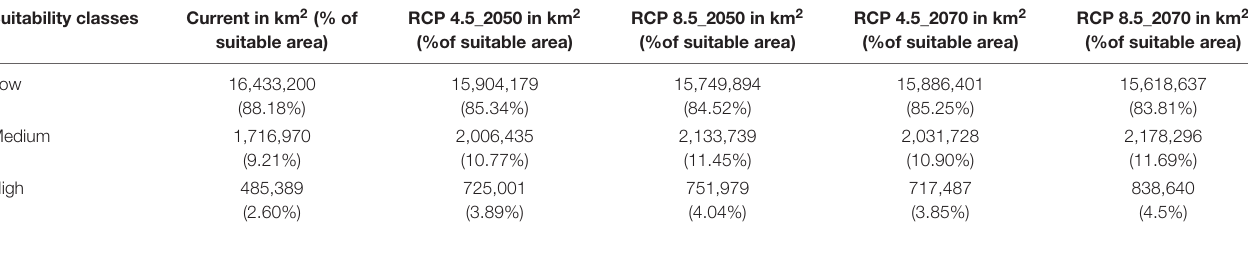
TABLE 1 | Results showing patterns of current and future suitability areas for wooly wolves under different suitability classes. Suitability